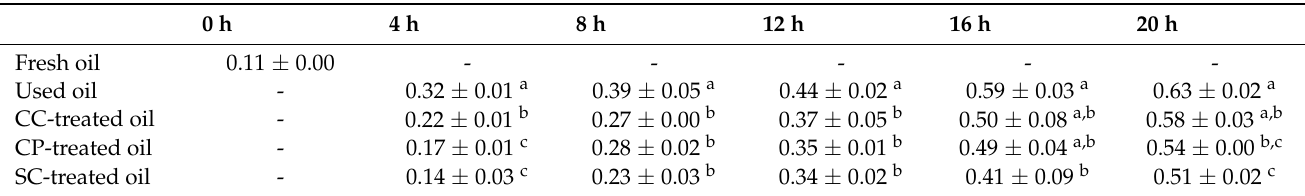
Table 3. Acid values (mg KOH/g oil) of the used and treated oils with different lignocellulosic biomasses; corn cob (CC), cornstalk piths (CP) and sugarcane bagasse (SC). Means with different letters ( a , b , c ) within each column indicate statistically significant differences between the samples after Duncan’s analysis ( p < 0.05). The numbers 4, 8, 12, 16 and 20 indicate the frying period by (h,